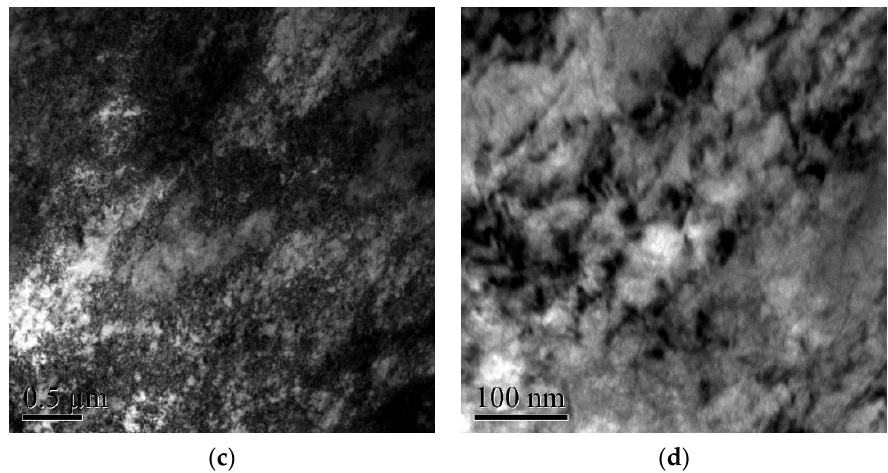
Figure 5. Bright field electron image of the deformed NiCrFeCoMn HEA impacted at the strain rate 2000 s − 1 . ( a ) Microbands; ( b ) microbands interacting with each other; ( c ) dislocation entanglement; ( d ) dislocation cell.